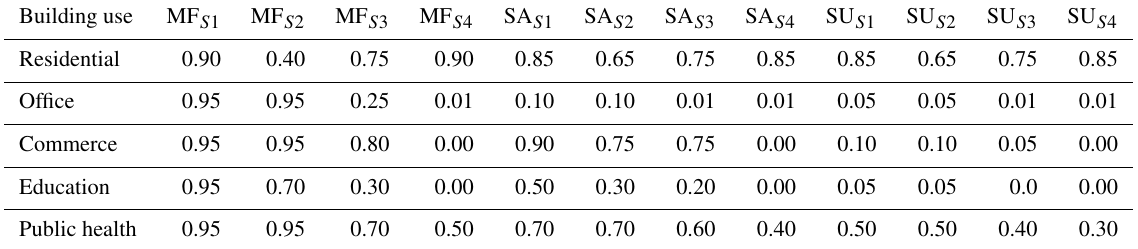
Table A2. Fractional building occupation ( f occ ) as a function of building use, time of day, and day of the week. The distinguished time intervals are Monday to Friday (MF), Saturday (SA) and Sunday (SU). The schedules S 1 to S 4 are defined in Table A1. We do not consider schedules of building occupation for the building uses “industry”, “agriculture”, “religious”, “sport”, “castle” and “non heated”. Building use